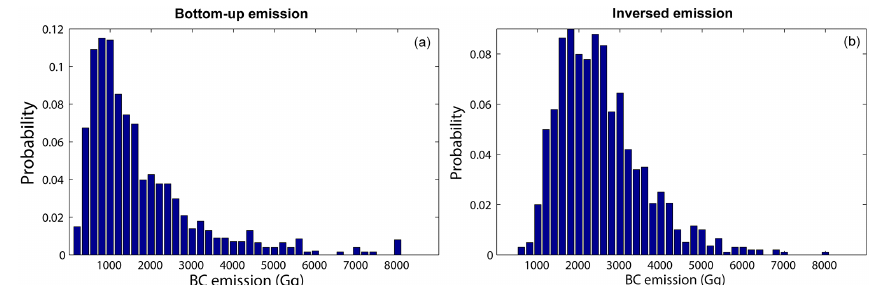
Figure 10. Uncertainty analysis for annual Chinese BC bottom-up and inverse emission